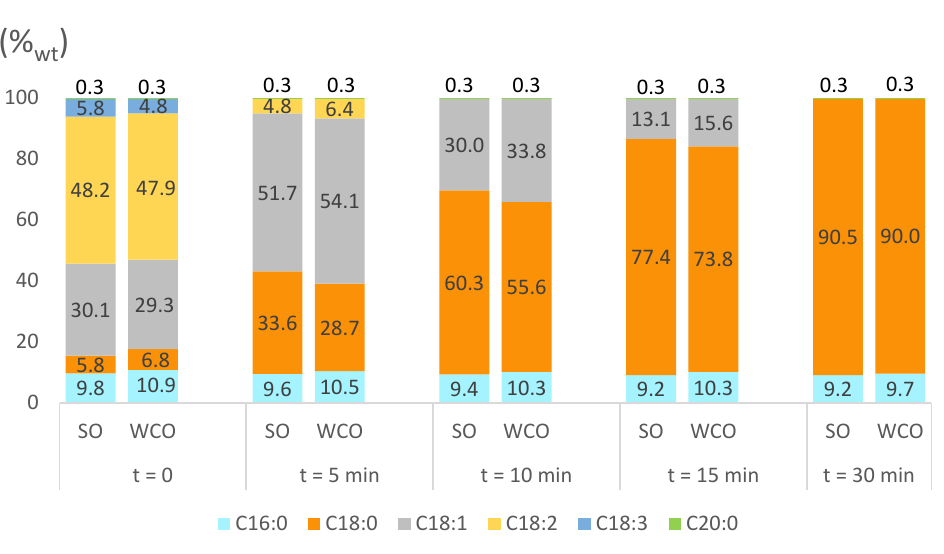
Figure 3. SO and WCO FAMEs compositions (% wt ) at different reaction times during hydrogenation with Pd-pol (2.8 mol% of Pd with respect to biodiesel (0.5 mmol, 125 mg), CH 3 OH (5 mL), RT, under H 2 (10 bar)).